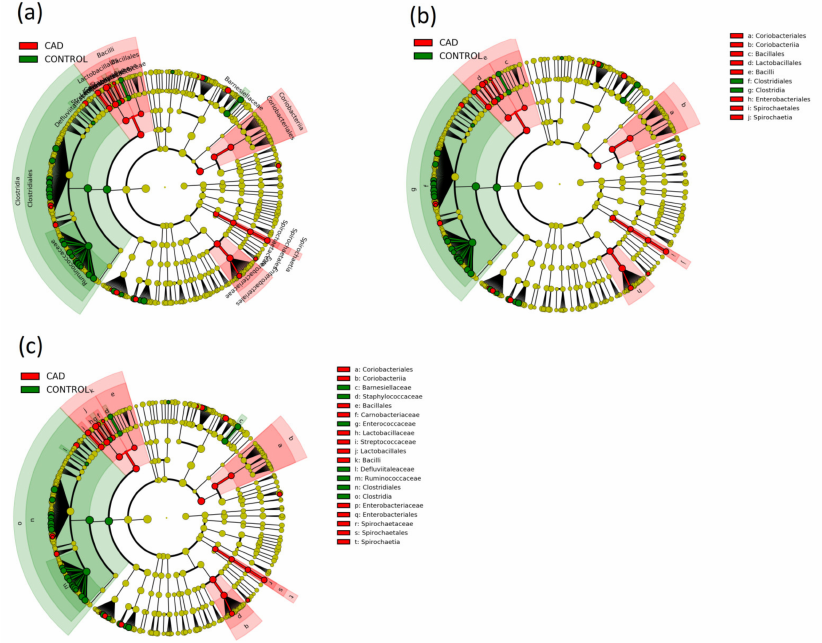
Figure 4. Cladogram showing various taxonomic changes in gut microbiota between the CAD and control groups: ( a ) general analysis; ( b ) in order level; ( c ) in order and class